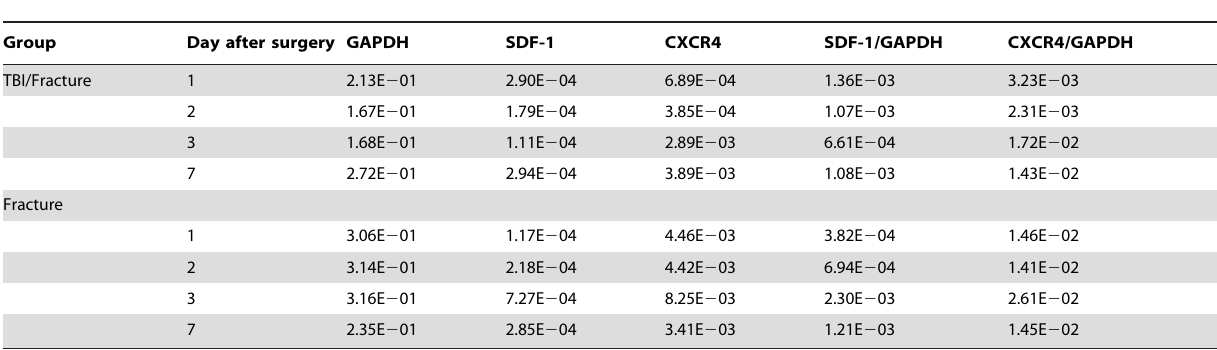
Table 1. Effects of SDF-1 on stem cell recruitment in vivo and in vitro.